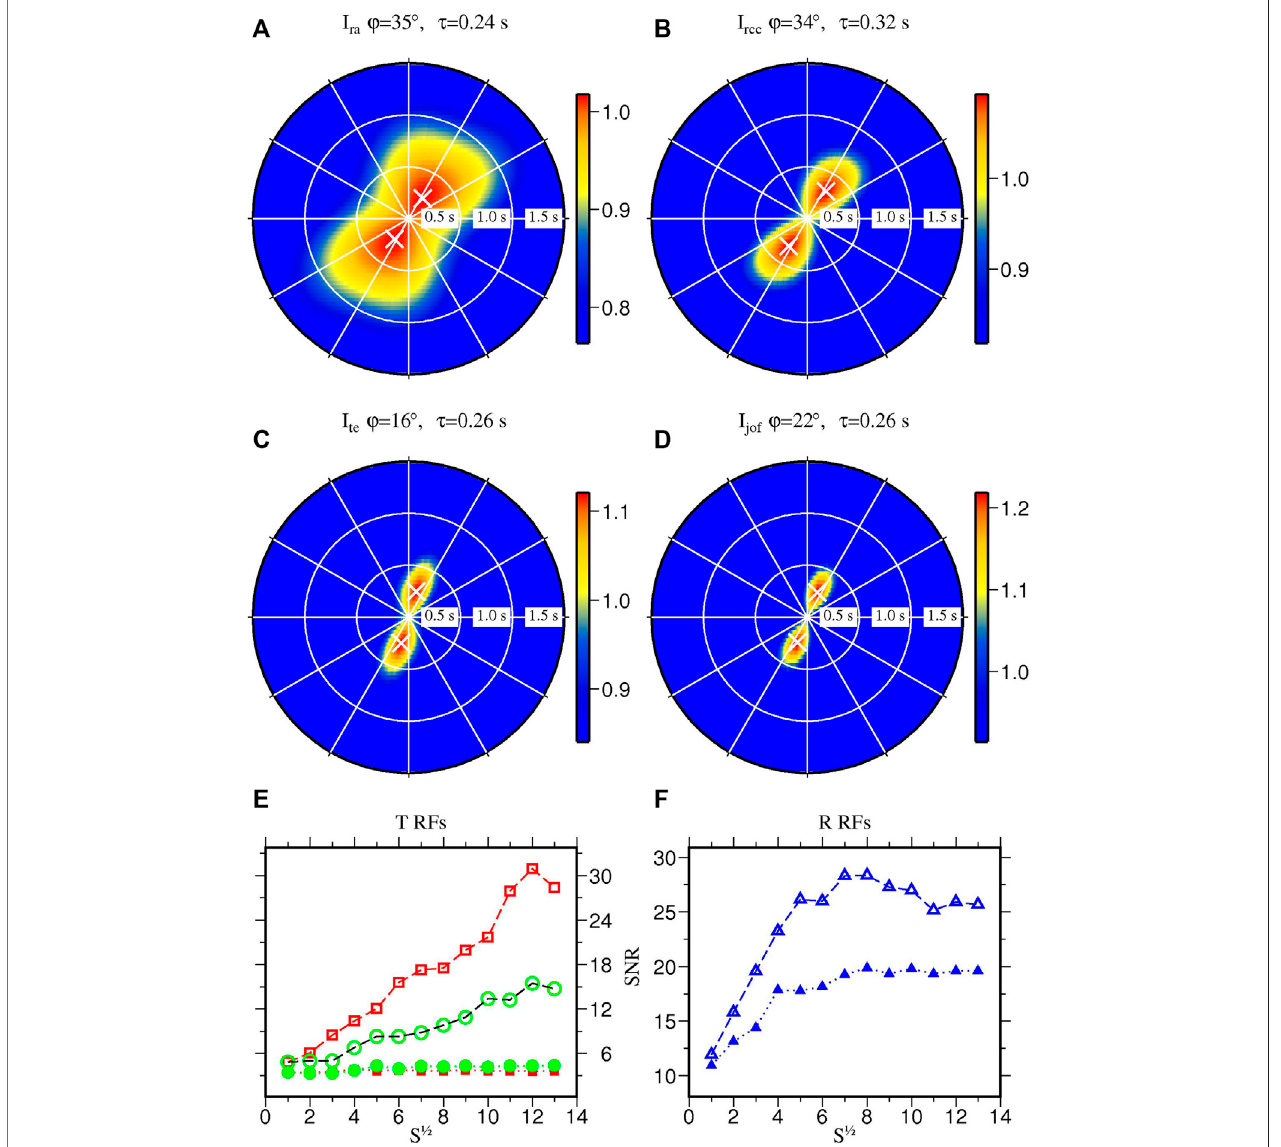
FIGURE3| Resultsofcrustalanisotropyfromthejointanalysiswithmulti-componentreceiverfunctiondataatstation15,819. (A – C) showthreeindividualmethods to estimate seismic anisotropy: 1) radial energy maximization with a cosine moveout correction; 2) radial correlation coef fi cient maximization; 3) transverse energy minimization. (d) is the joint solution. ( φ , τ ) are searched in the range of 0 – 360 ° and 0 – 1.5 s with an increment of 1 ° and 0.02 s, respectively. White plus marks the measured( φ , τ )wheretheobjectivefunctionsreachtomaximum. (E,F) showthecalculatedSNRsofstackedreceiverfunctiondataasafunctionofthesquareroot of the subsample numbers, S 1/2 . Open and fi lled symbols in (E,F) indicate SNR calculated from stacks of receiver functions before and after the removal of seismic anisotropymeasuredbythejointreceiverfunction.Morespeci fi cally,openedsquaresshownin (E) indicatestacksfromTreceiverfunctionswithoutanisotropycorrection but with polarity correction, while opened circles are from T receiver function with no corrections of anisotropy and polarity. Filled squares and circles represent stacks after correction of anisotropy, and with and without polarity correction, respectively.